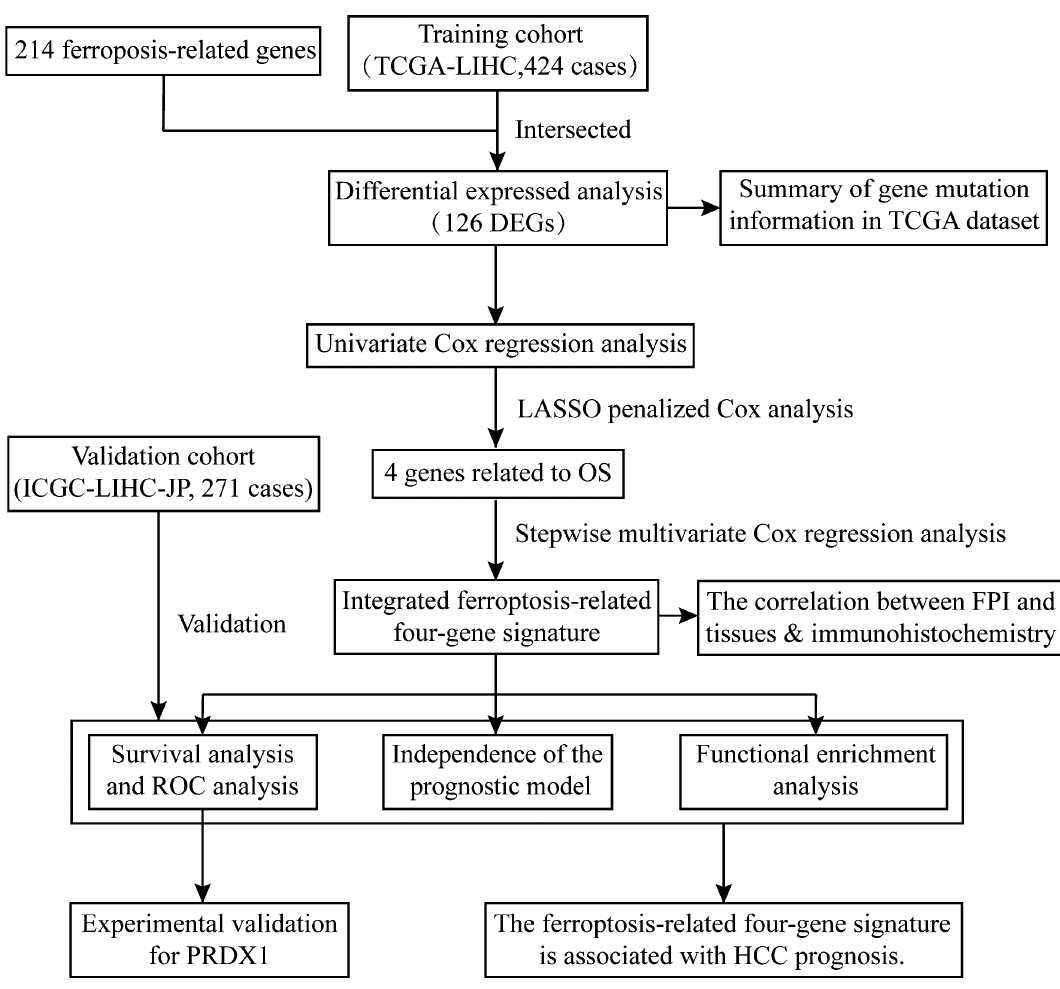
Figure 1. A flow chart for overall study